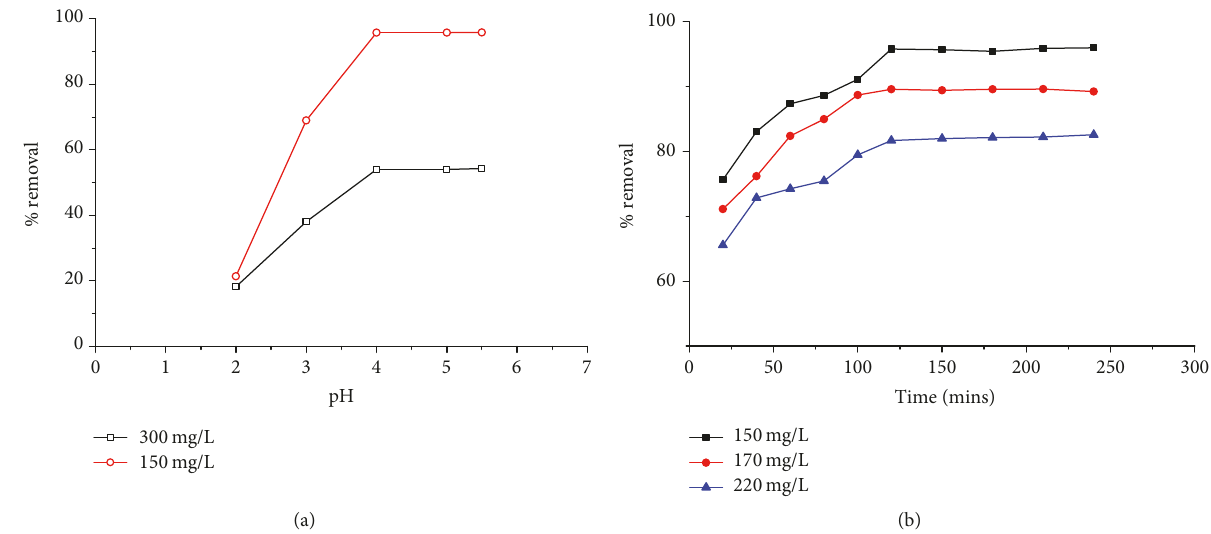
Figure 4: Effects of pH (a) and contact time (b) on the adsorption of Co(II) onto the 𝛾 -MnO 2 nanomaterial at different initial concentrations of cobalt.